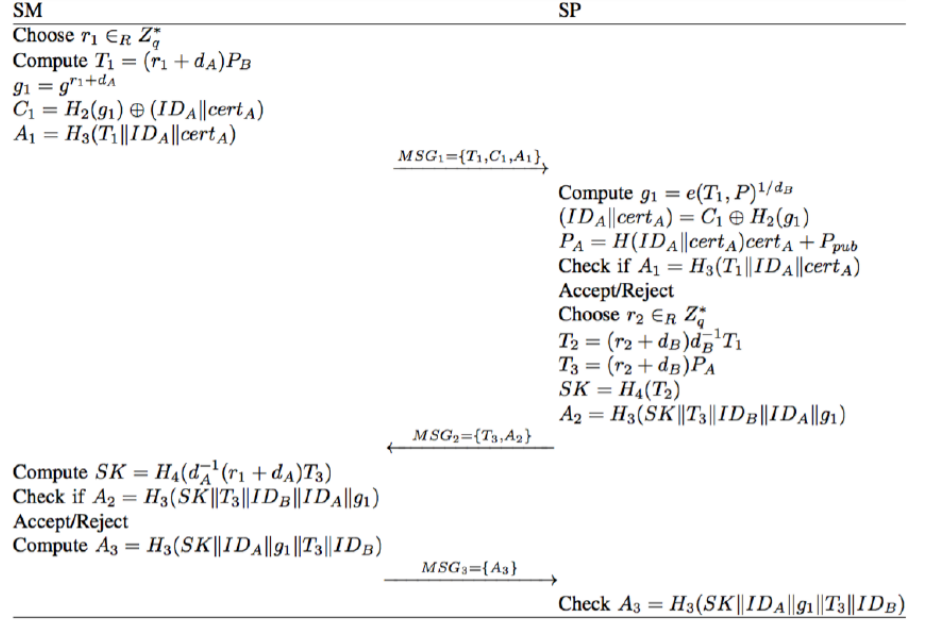
Figure 3. Review of key agreement phase of Chen et al.’s scheme